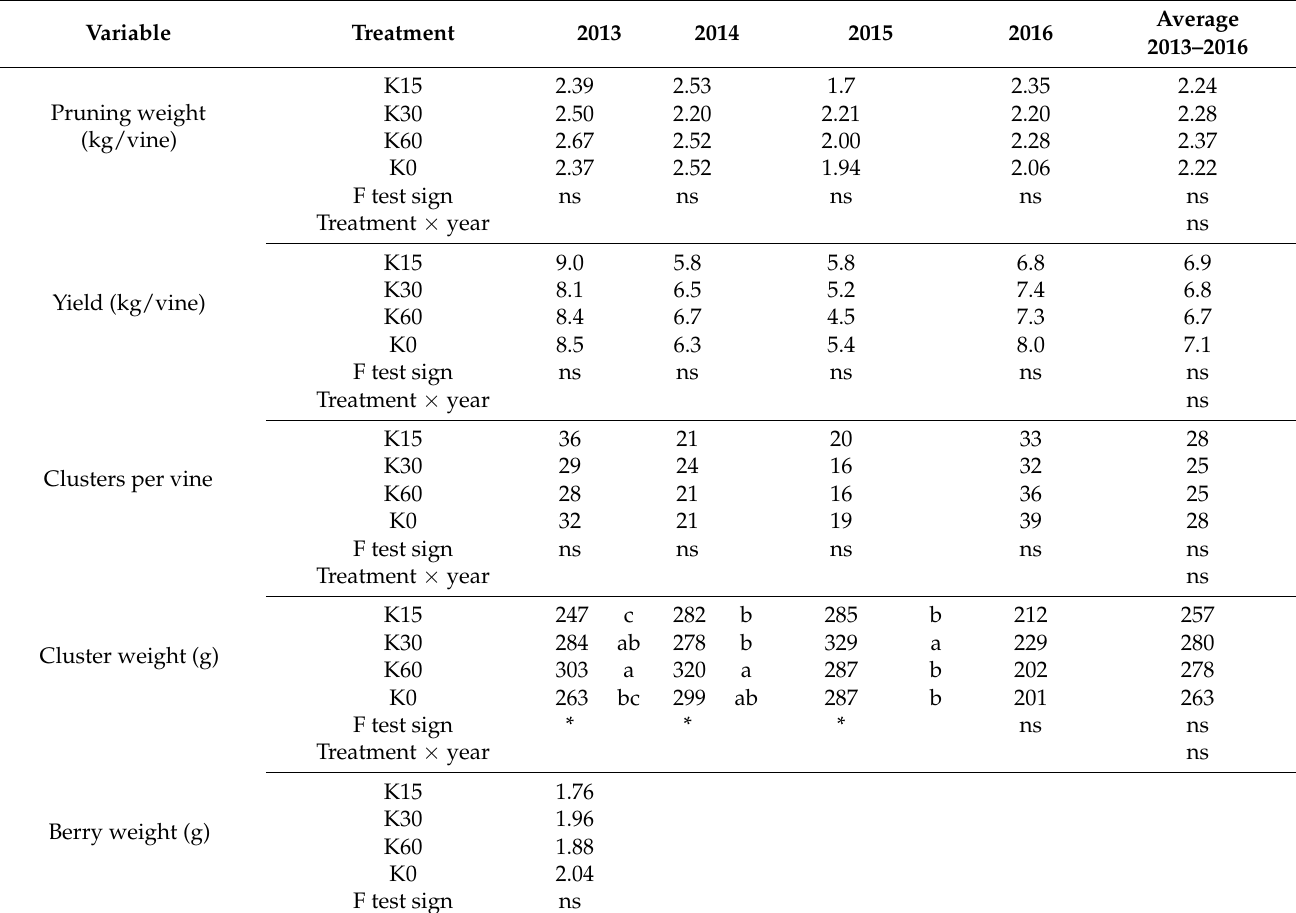
Table 3. Yield components and pruning weight of Glera vines in response to different potassium fertilization. Means followed by different letters differ significantly by Fisher’s least significant difference test (* = p ≤ 0.05; ns: